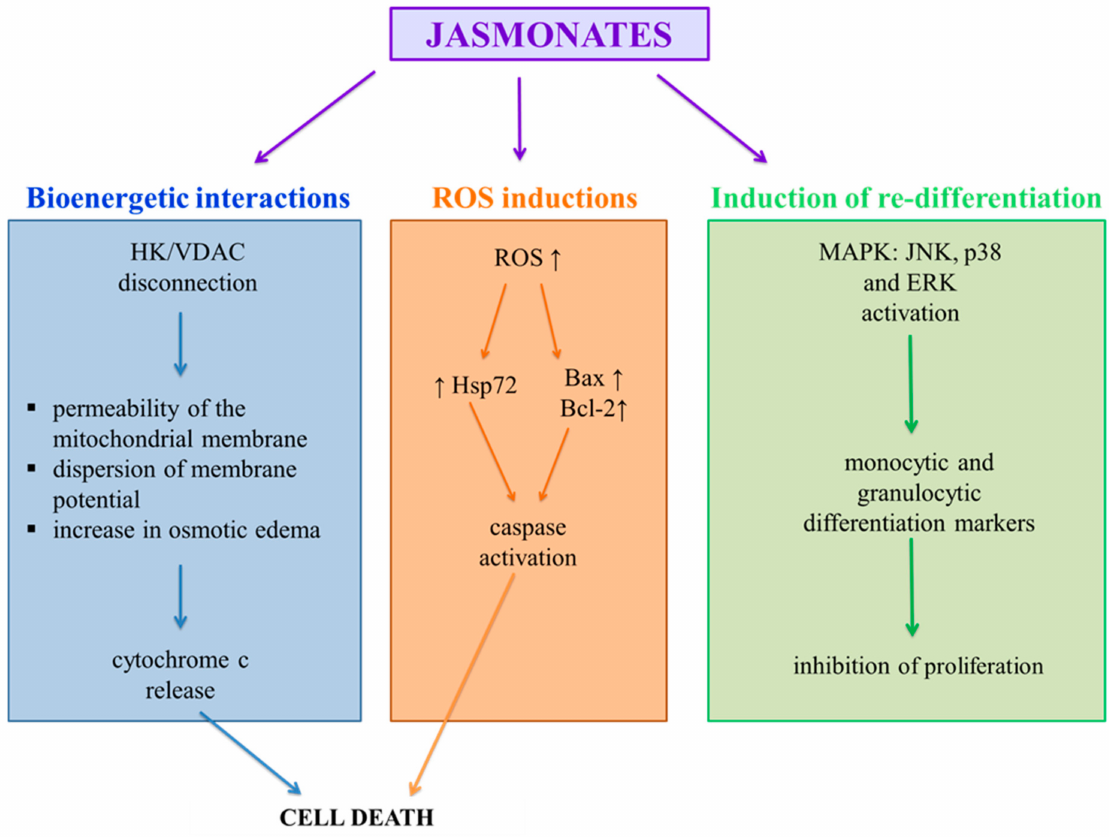
Figure 2. Antitumor mechanism of action of jasmonates. HK—hexokinases; VDAC—Voltage-dependent anion-selective channel 1; ROS—reactive oxygen species; MAPK—Mitogen Activated Protein Kinases; JNK—c-Jun N-terminal kinases; p38 protein; ERK—extracellular signal-regulated kinases; Hsp72—heat shock protein 72; Bax/Bcl-2—protein